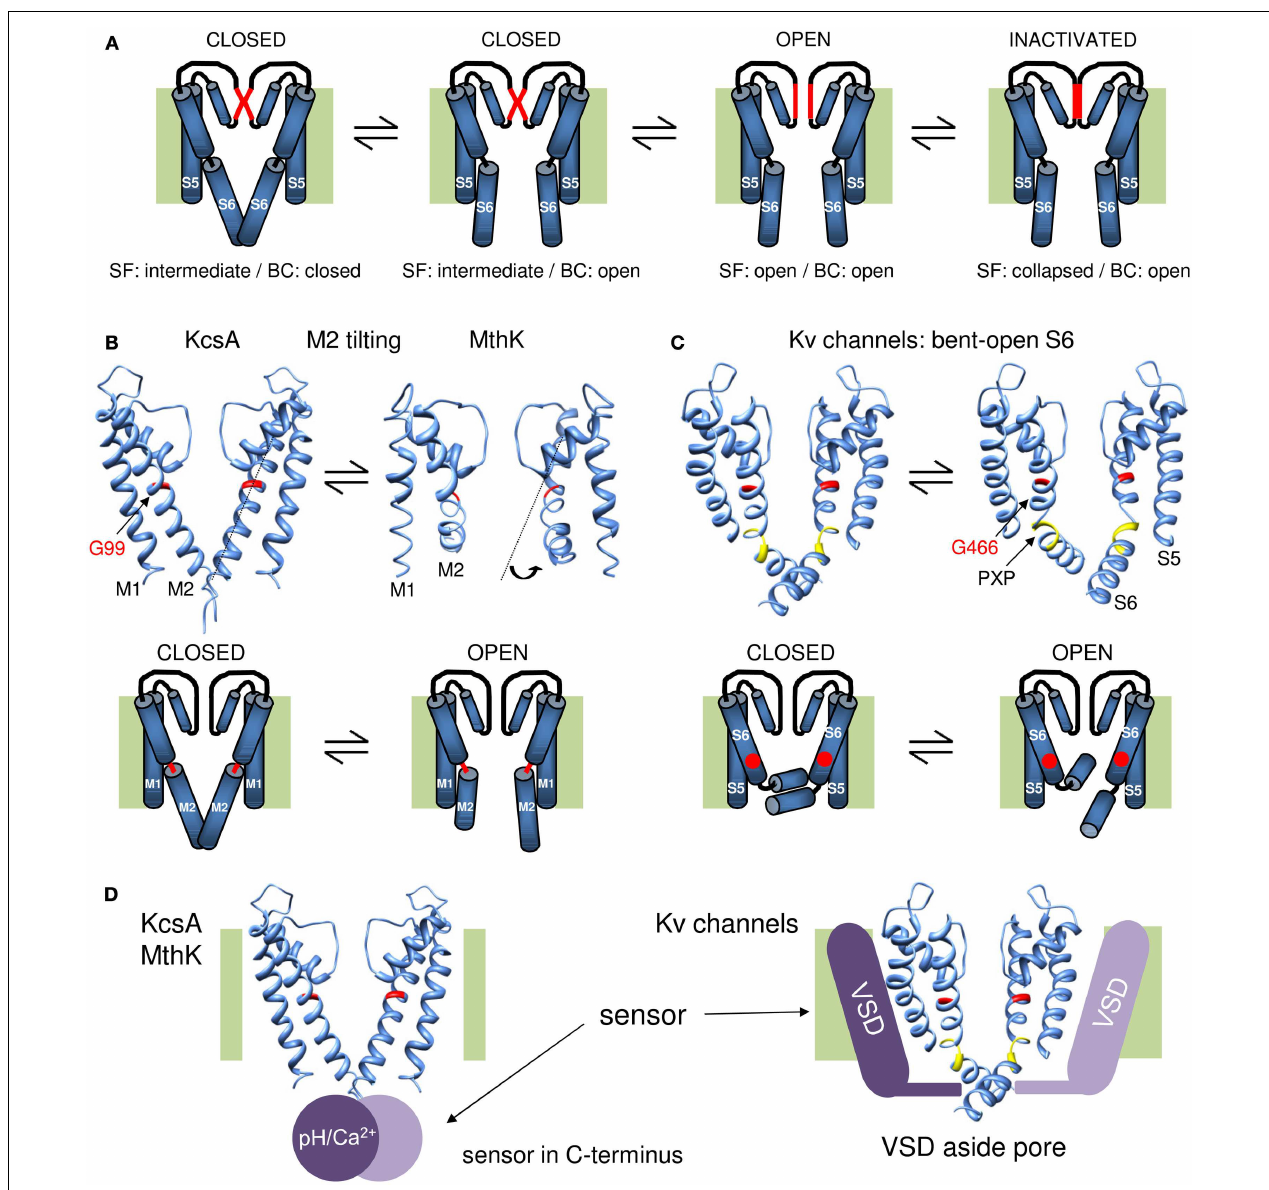
opening of the BC gate requires tilting of the post-hinge M2 segment. (C) Proposed gating mechanism for Shaker -type Kv channels. On the right the 3D crystal structure of the Kv1.2 channel in the open conformation and on the left a model for the closed state built by Pathak et al. (2007). Note that the inner S6 pore helix remains bent in both closed and open conformation resulting in the “bent-open S6 model” for channel gating.The glycine counterpart that forms the hinge in KcsA/MthK is G466 (indicated in red). However, the bend in S6 is not at this glycine residue but at the conserved PXP motif (colored yellow) located seven residues further downstream. Below a cartoon representation of the proposed gating mechanism whereby G466 is indicated with a red dot. In contrast to the mechanism in (B) , most of the reorientations in S6 occur in the vicinity of the PXP motif. (D) Illustration for the location of the stimulus sensor in KcsA/MthK vs. Kv channels. Left: the 3D structure of KcsA with the pH sensor (Ca 2 + sensor in case of MthK) indicated with a purple sphere that locates in the C-terminus underneath the inner M2 pore helix. Right: the Kv1.2 structure with theVSD indicated with a purple bar situated besides/adjacent to the K + pore.The different location of the stimulus sensor that controls the status of the BC gate may explain their different gating mechanism proposed in (B,C)